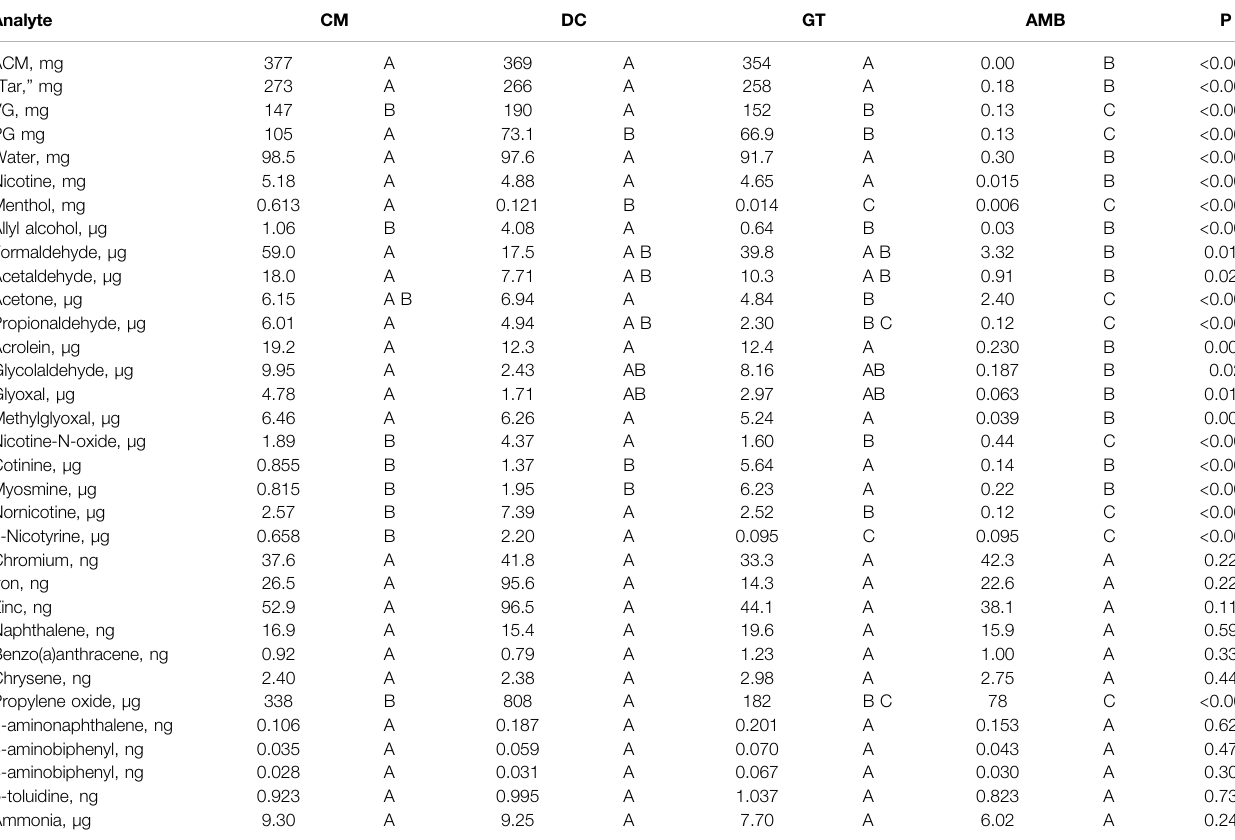
TABLE 5 | Means (per collection) and ANOVA results for analytes with at least one quanti fi able result.